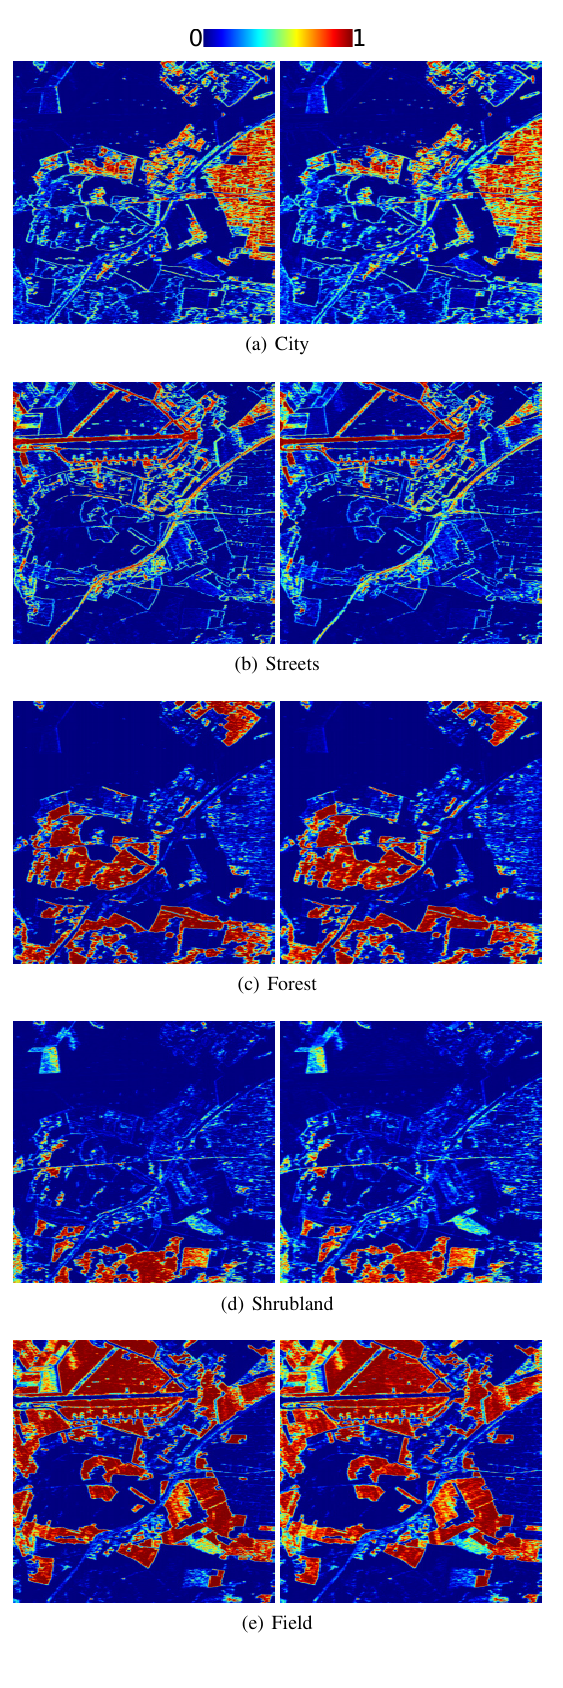
Figure 9. Class posterior of the test samples (acquired over all folds) of the initial (left) and final (right) model.